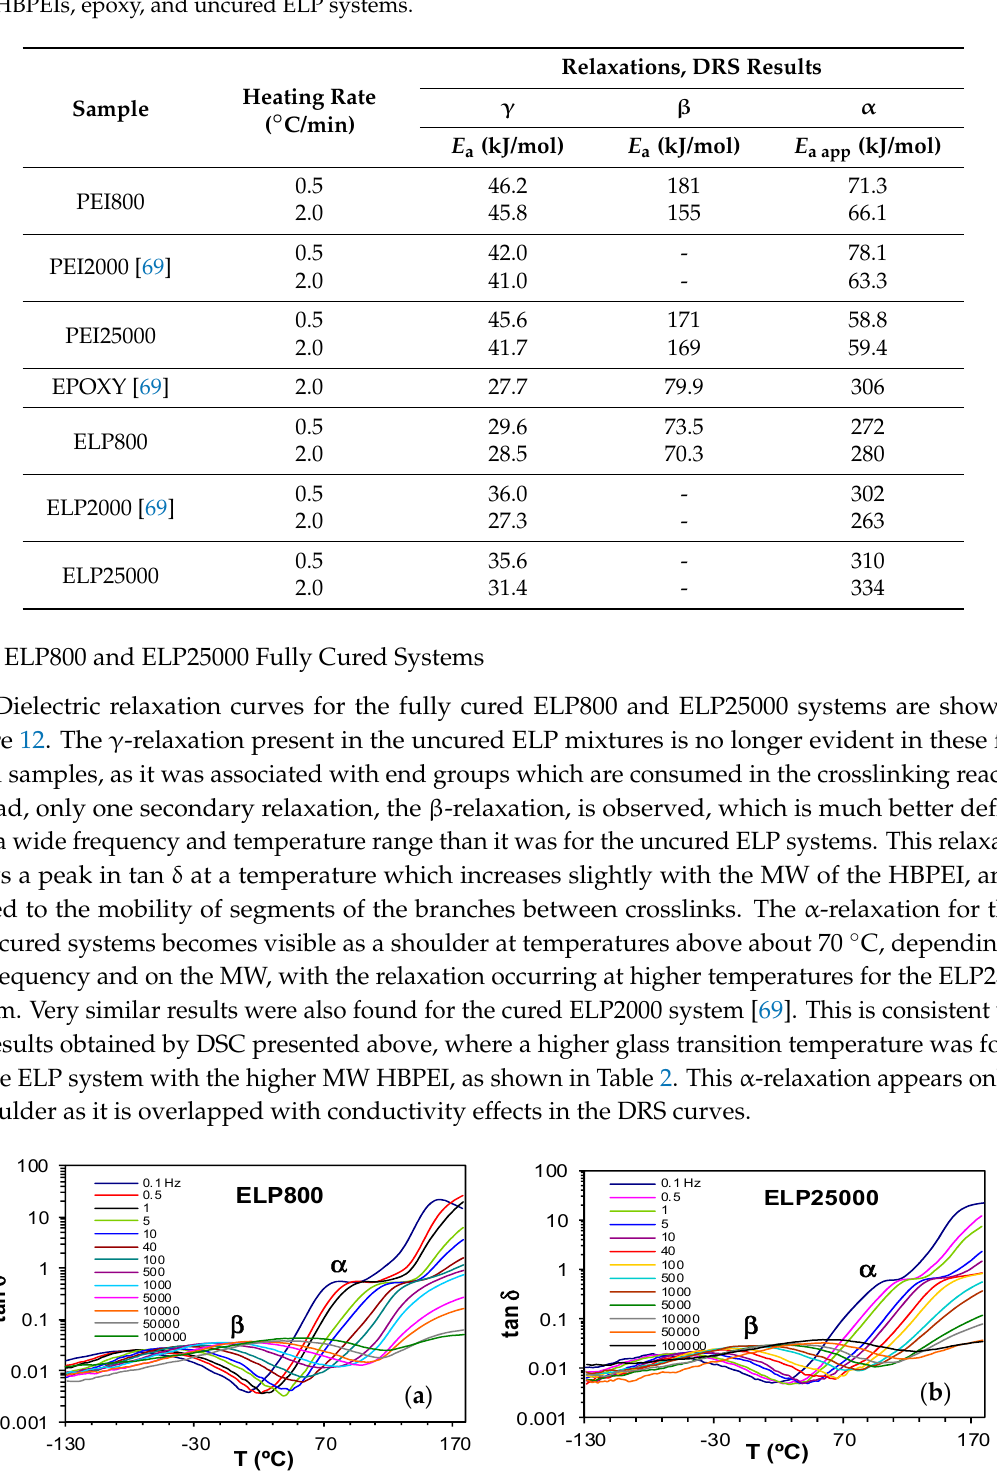
Figure 12. Dielectric relaxation curves at 2 °C/min for the fully cured systems: ( a ) ELP800; ( b ) ELP25000.